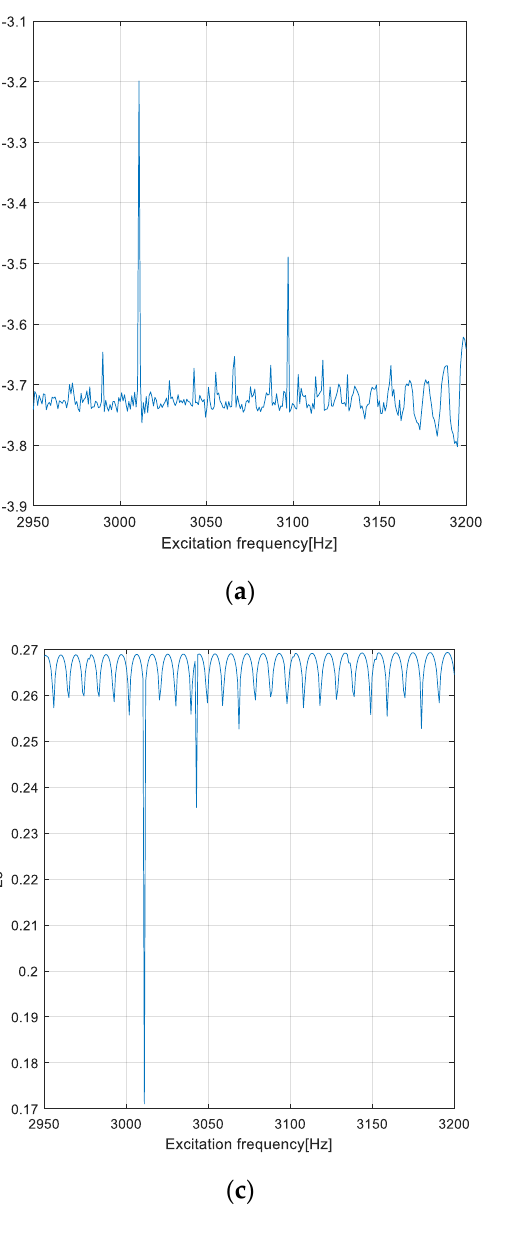
= 9 0 , ξ = 1.6 · 10 − 3 1